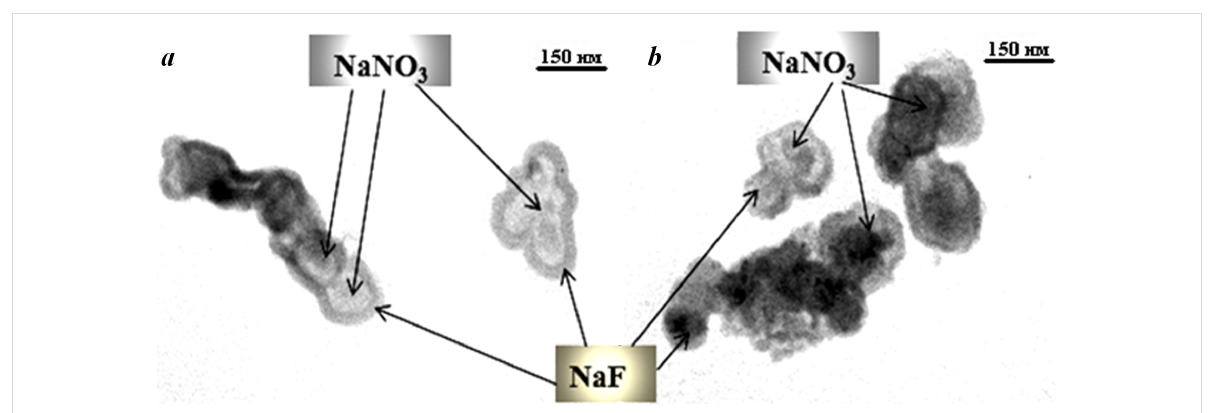
Figure 10: TEM images of sub-micrometer-sized NaNO 3 –NaF powders containing 3 wt % ( а ) and 15 wt % (b) of NaF additive. The scale bar repre- sents 150